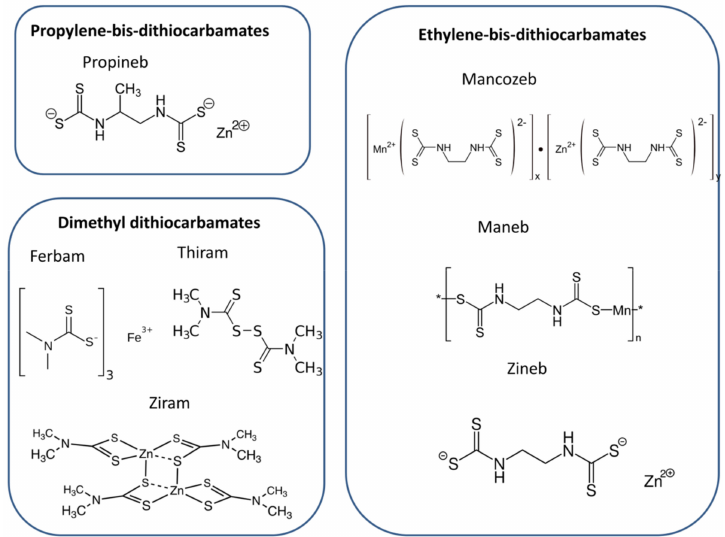
Figure 1. Classification of dithiocarbamate fungicides (DTF) and chemical structures of main repre- sentatives from each group.